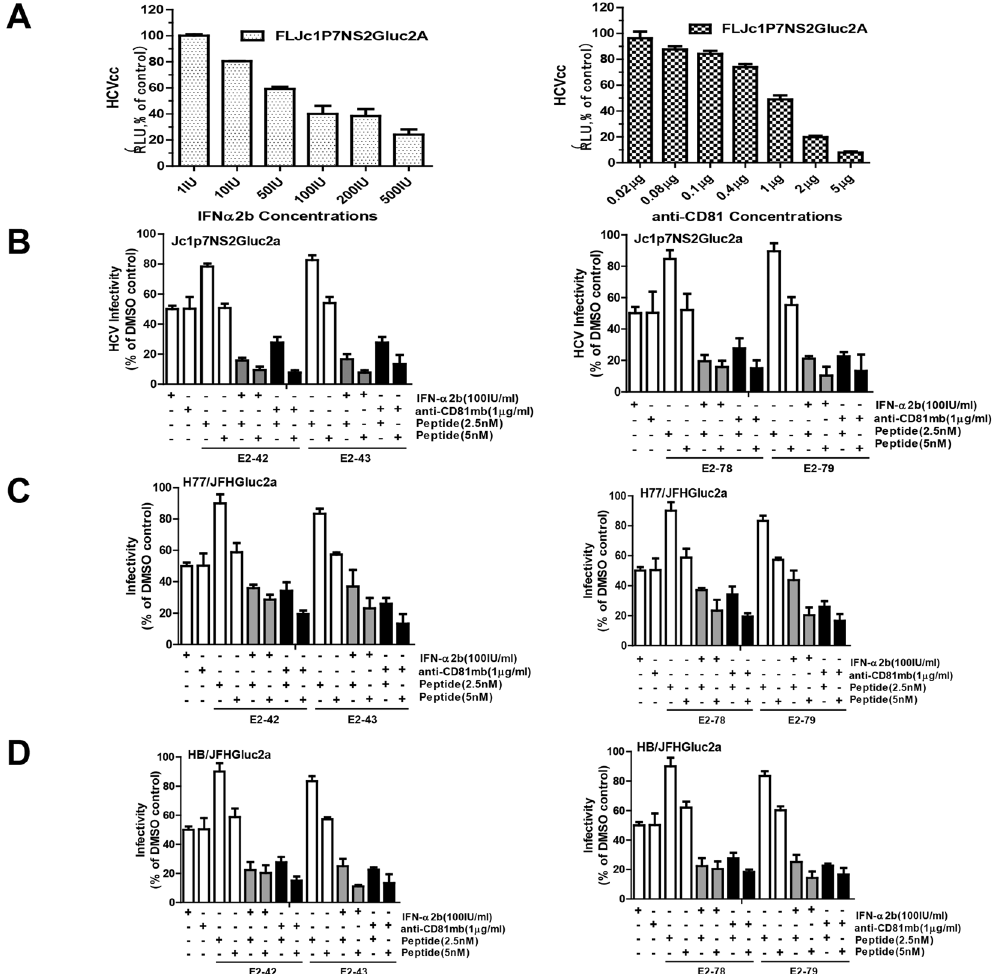
Figure 5. Analysis of the combination effects of the peptides combined with IFN- α 2b and anti-CD81 antibodies. ( A ) Determination of the EC50 of IFN- α 2b and anti-CD81 antibodies for HCVcc. Huh7.5/CD81 cells were seeded at 1 × 10 4 /well in 96-well plates the day before infection. The cells were infected with 0.05 FFU/ cell mixed with serial dilutions of IFN- α 2b and anti-CD81 antibodies. Gaussia luciferase activity was measured 72 h later. DMSO treatment served as a negative control. ( B , C , D ) The inhibitory effects of the peptides in combination with IFN- α 2b or anti-CD81 antibody against HCV infection was assayed with chimeric HCVcc. Huh7.5/CD81 cells were treated with peptides, IFN- α 2b or anti-CD81 antibodies and infected with different genotypes of chimeric HCVcc. The Gaussia luciferase activities of Jc1P7NS2Gluc2a ( B ), H77/JFHGluc2a ( C ), HB/JFHGluc2a ( D ) were assayed 72 h later. HCV infectivity was expressed as the percentage of the DMSO control. Each bar represents the average of triplicate data points, with the standard deviation represented by the error